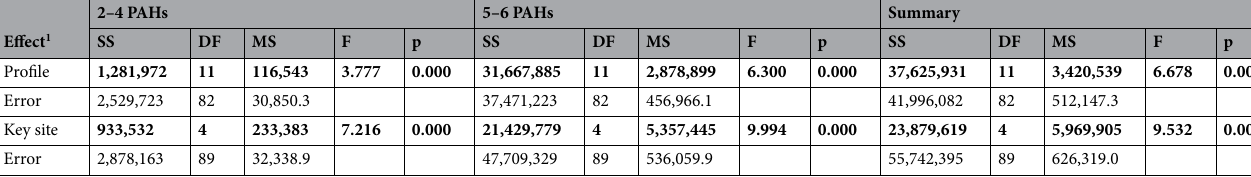
Table 1. ANOVA results of the significant differences of PAH concentrations in the studied peat plateaus. 1 Significant effects (p < 0.05) are in bold.